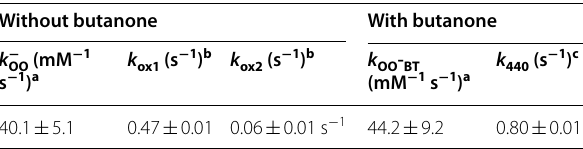
CHMO. In contrast, the second order rate constant for the reaction between O 2 and the reduced FAD in ACMO (49 mM − 1 s − 1 ) was 20–30-fold lower. The C4a-perox- yflavin is also not as stable in ACMO even in the pres- ence of saturating amounts of NADP + as it decayed with a rate constant of 0.47 s − 1 in the absence of substrate. The instability of the C4a-peroxyflavin intermediate likely accounts for the relatively high rate of uncoupled NADPH oxidation (0.26 s − 1 ) in ACMO. The NADPH oxi- dase activity of CHMO and PAMO is 50-fold and 150- fold lower, respectively, than that of the monooxygenase activity (Torres Pazmino et al. 2008; Sheng et al. 2001), but in ACMO it is only tenfold lower. It is unclear why